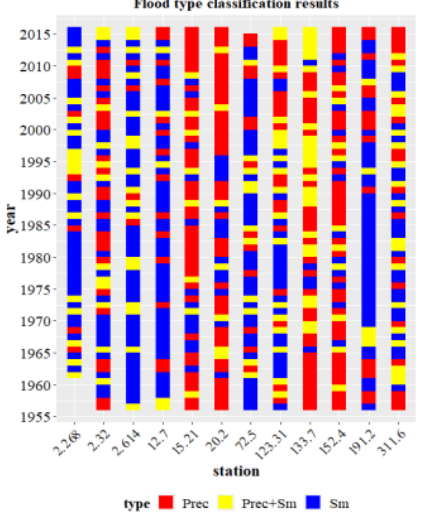
Figure 3. Classification results of FGMs using the rainfall–flood ratio indicators. The flood events are classified by rainfall–flood ratio, indicated by 1/3 and 2/3 lines. Pink dots represent floods caused by rainfall, blue dots represent the interaction of rainfall and snowmelt, and red dots represent floods induced by snowmelt.